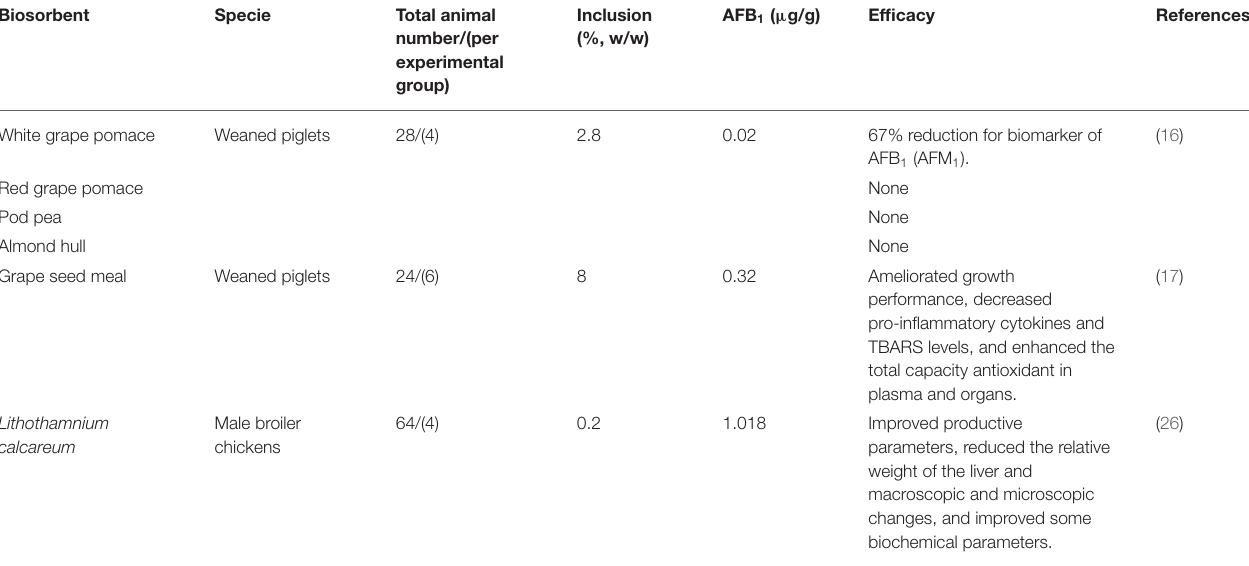
TABLE 2 | In vivo efficacy of agro-waste-based materials in counteracting the harmful effects of aflatoxins.